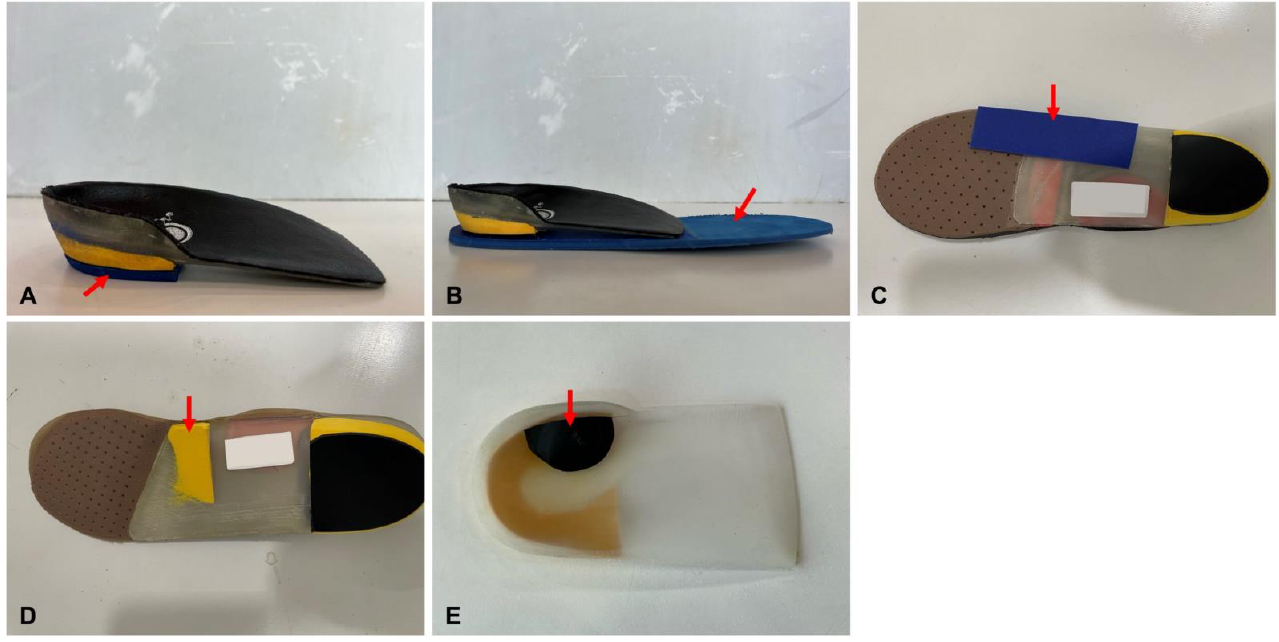
Figure 2. Photographs of ( A ) heel lift, ( B ) entire lift, and ( C ) lateral wedge, ( D ) medial wedge, and ( E ) calcaneocuboid arch supports. ( E ) calcaneocuboid arch